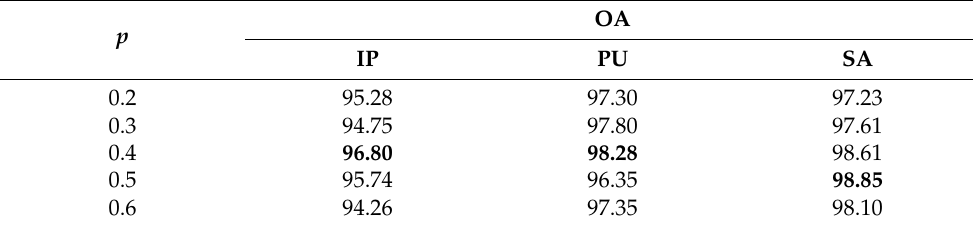
Table 7. Comparison of OA with different dropout ratios for the three datasets.